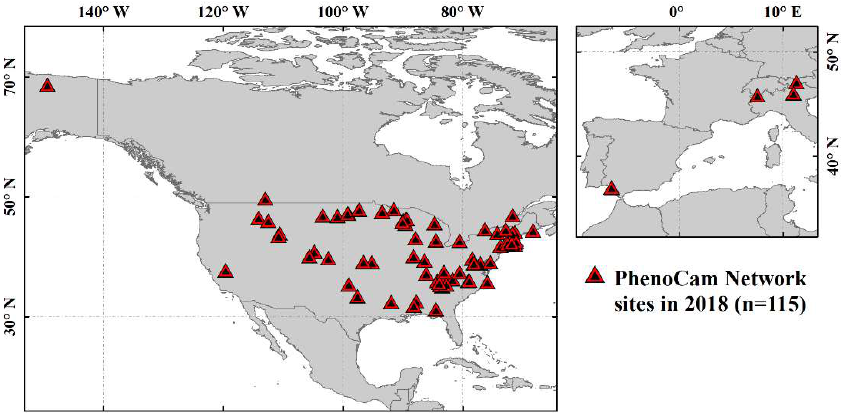
Figure 1. Spatial distribution of near-surface phenology observation sites from PhenoCam Network.